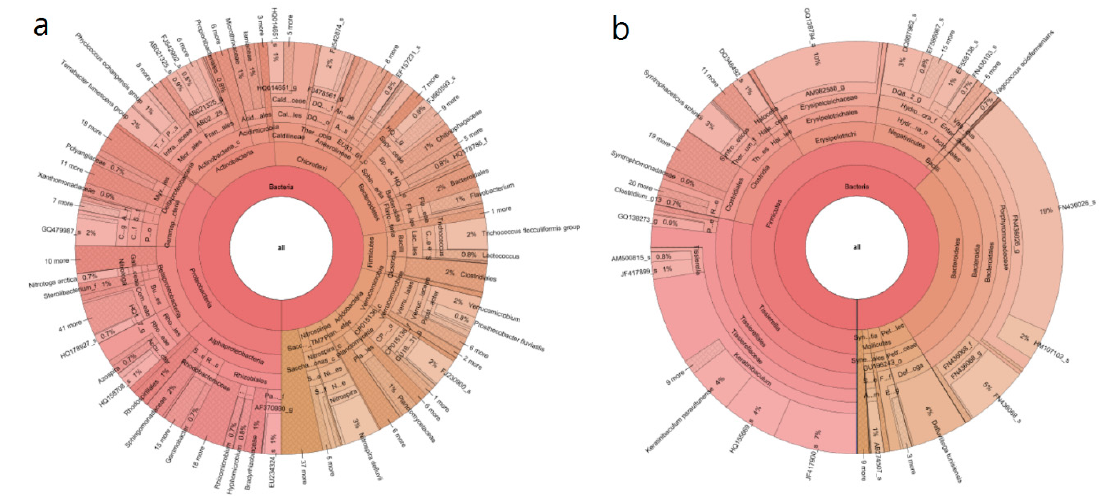
Figure 4. Results of bacterial communities analysis in AD ( a ) and BEAD ( b ) reactors at the end of S3 (6.0 kg/m 3 ·d).